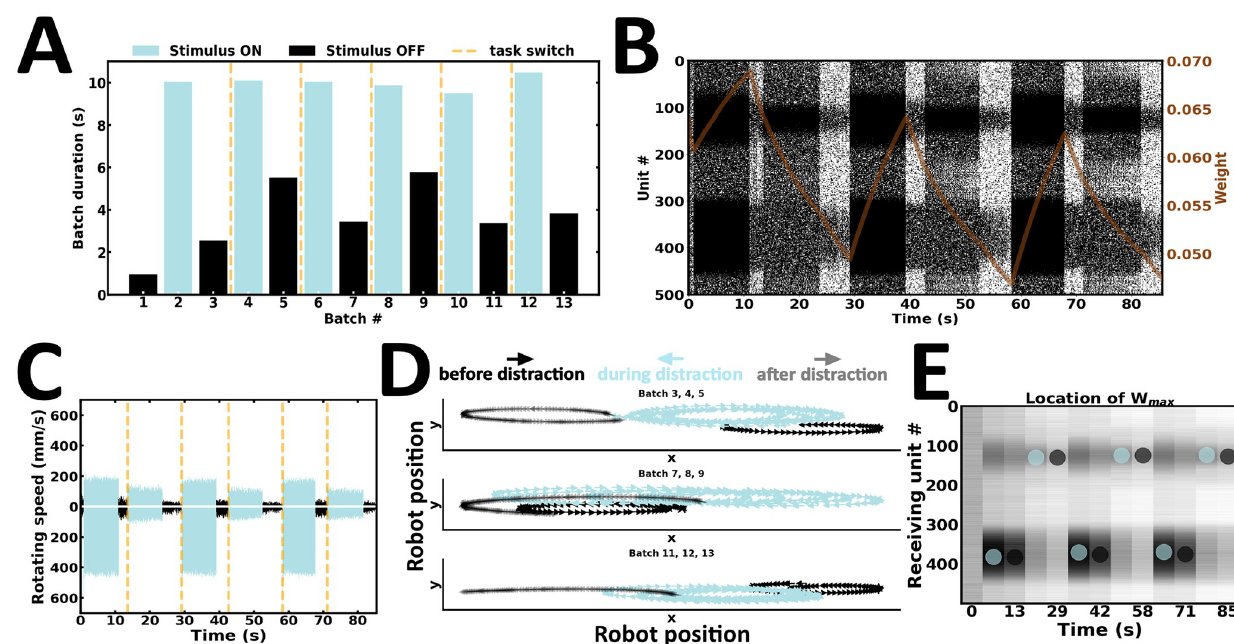
Fig 13. Resisting distraction inputs. (A) Duration of alternating batches of evoked and spontaneous activity. (B) Raster plot of network activity. Distraction inputs fail to disrupt cue-guided patterns of local persistent activity; brown curve, average synaptic efficacy. (C) Rotating speed of left and right wheel motors as a function of time. (D) Motor trajectory of the robot before, during and after the presentation of distraction inputs. (E) Spatial location of the highest average incoming synaptic weights; blue and black dot, evoked and spontaneous activity, respectively.